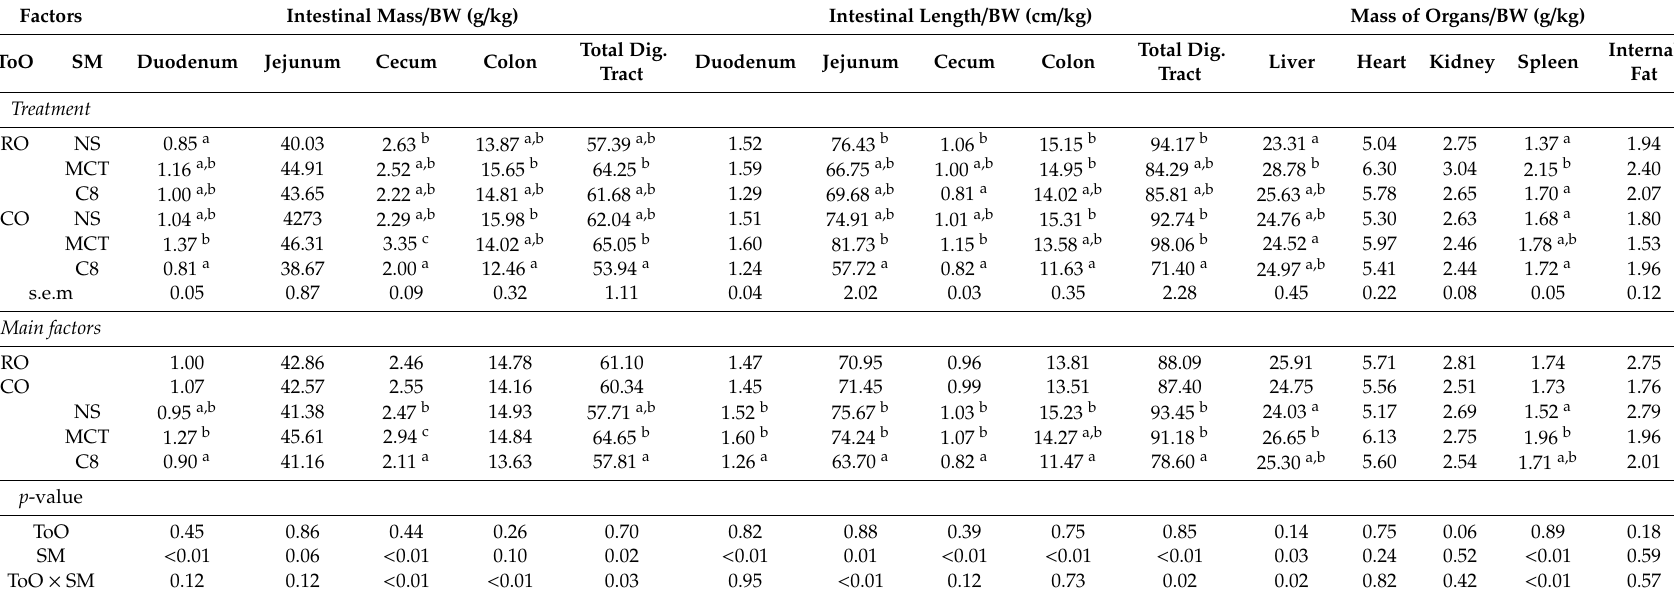
Table 8. Mass and length of piglet intestines and mass of internal organs at 60th day of